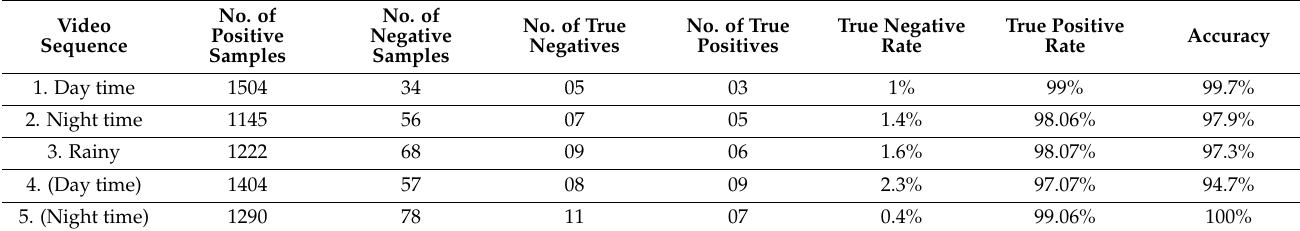
Figure 12. Performance of the proposed lane detection model. Table 3. Lane detection accuracy of the algorithm under different scenarios.